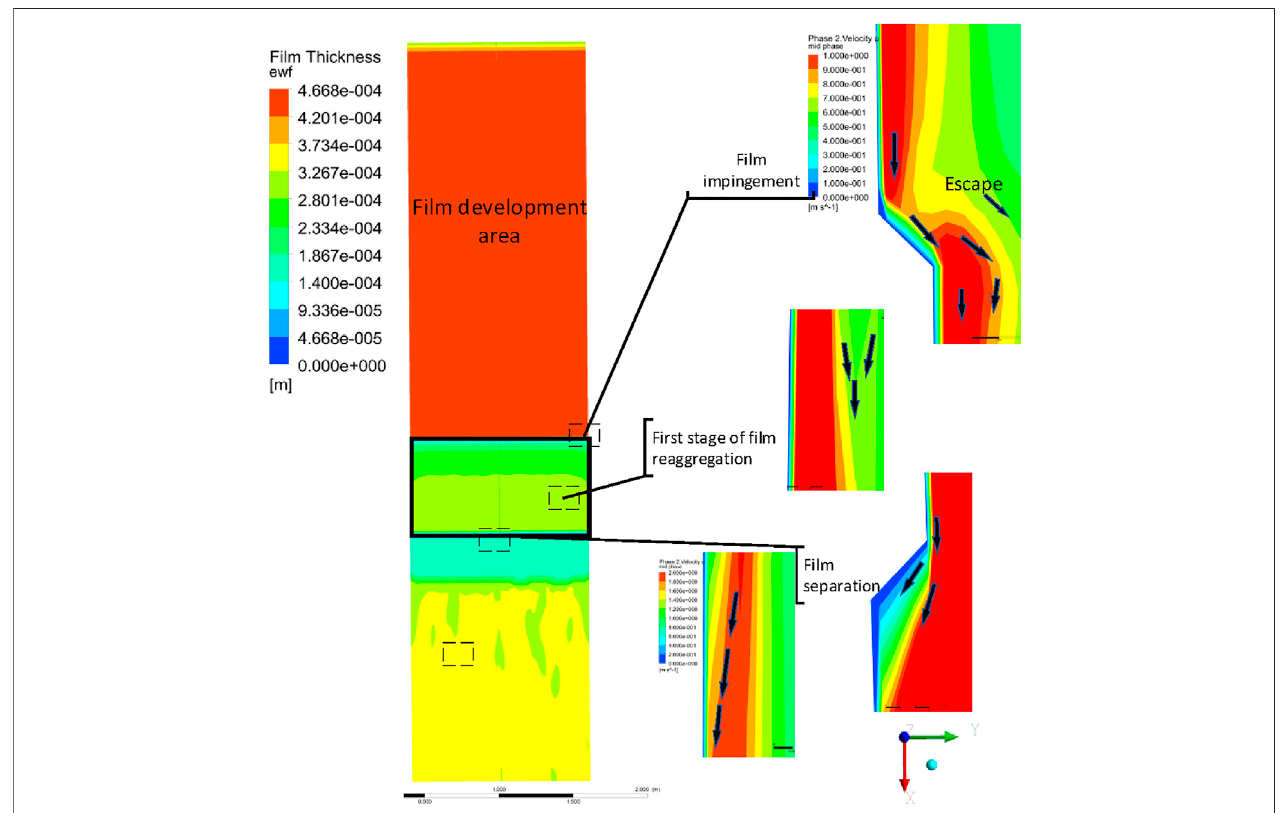
FIGURE 8 | Analysis of falling fi lm thickness and velocity fi eld.